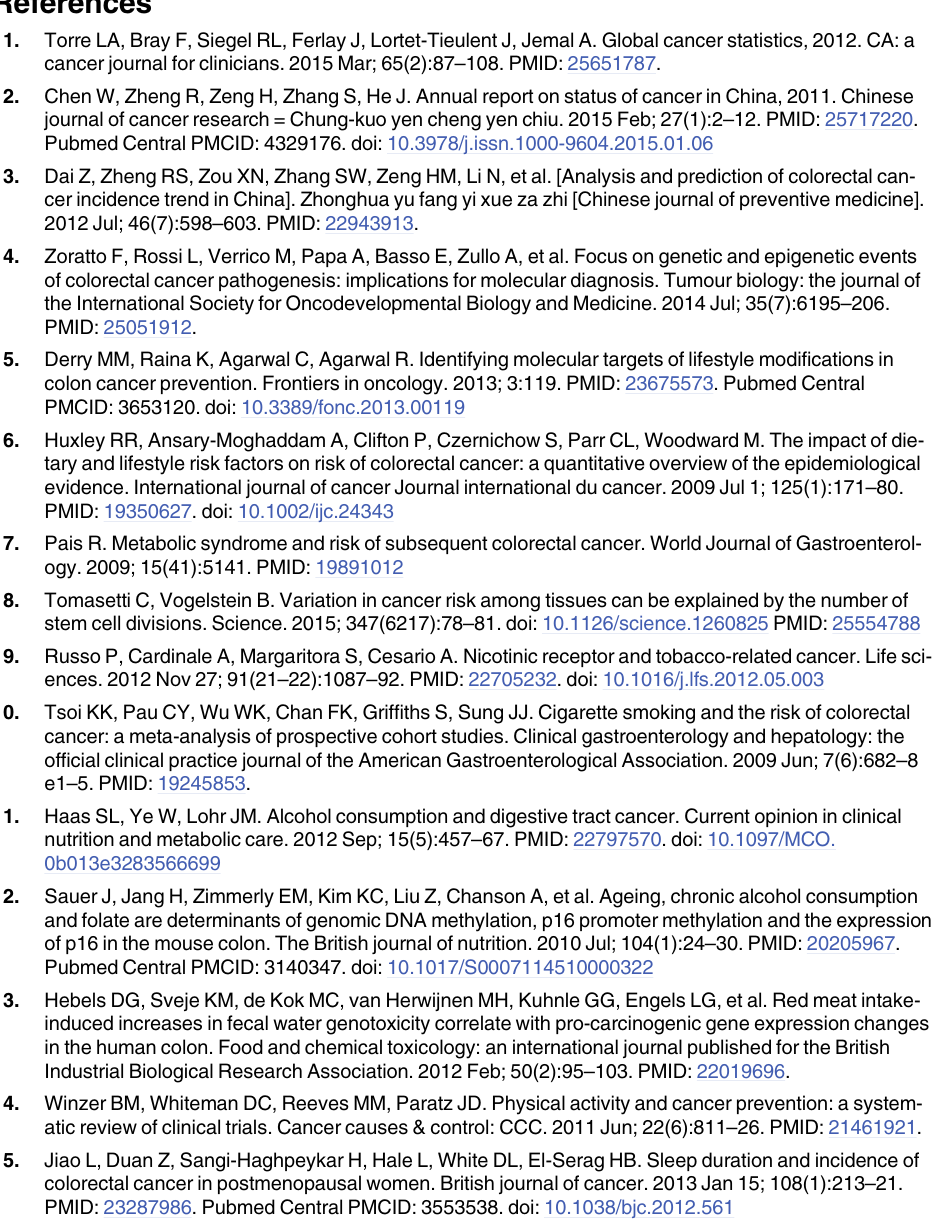
S5 Table. Synergistic effects of lifestyle factors and comorbidities history on colorectal can- cer risk. Abbreviation: S, the synergism index; OR was adjusted for sex, age, BMI, educational level and history of colorectal cancer in first-degree